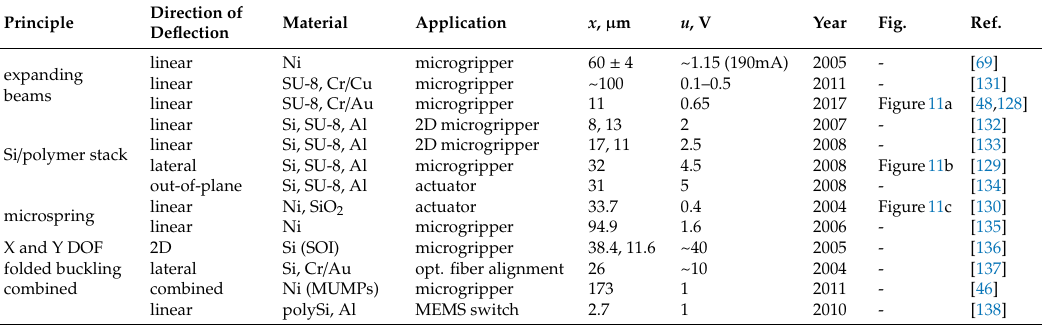
Summary of unconventional electrothermal actuators ( x —maximum displacement demonstrated, u —corresponding driving